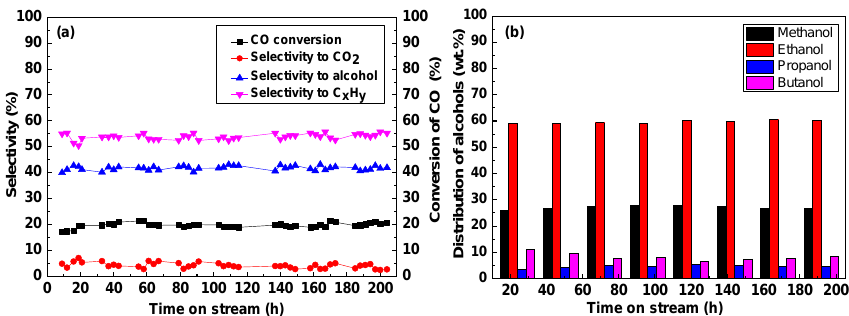
Figure 7. ( a ) Stability performance and ( b ) alcohols distributions (seen from the illustration) of the LKCG-0.1 catalyst after 200 h reaction at T = 290 °C, P = 4 MPa, GHSV = 6000 mL g cat − 1 h − 1 , and H 2 /CO/N 2 = 8/4/1.